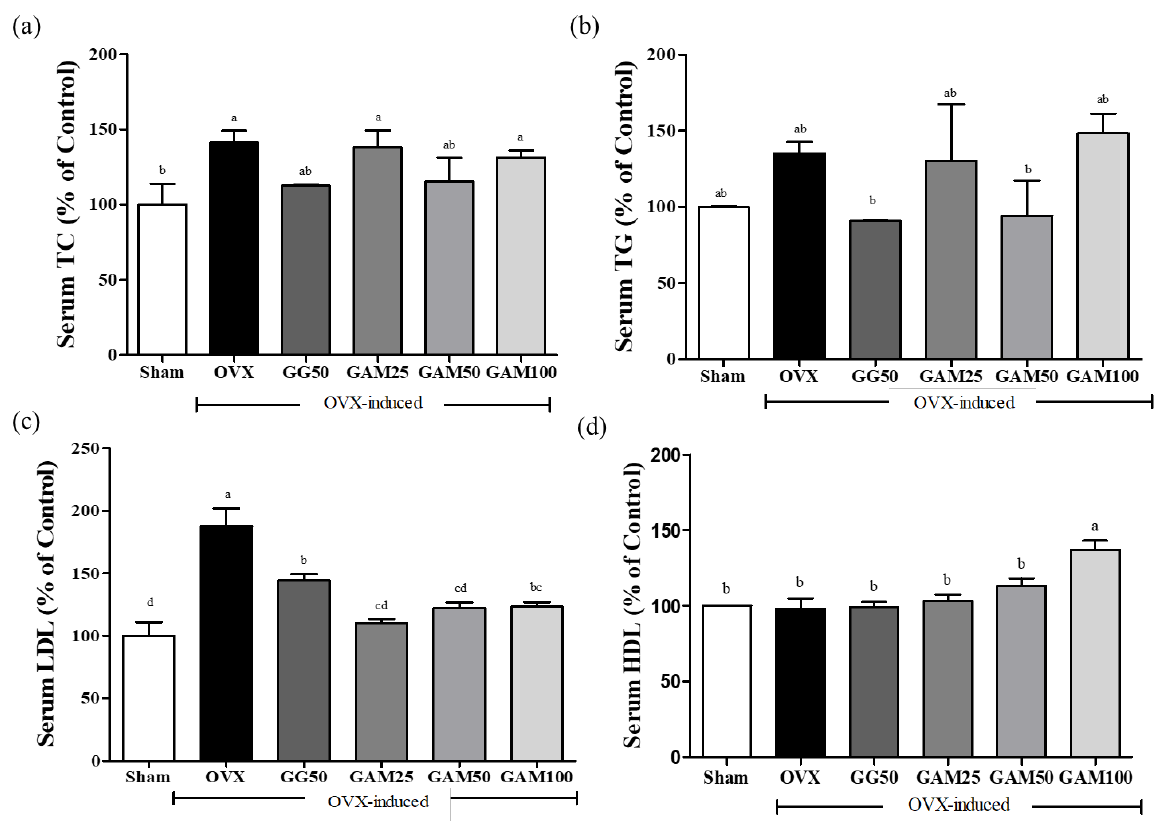
Figure 1. Effects of GAM on body lipids on OVX-induced rat models. The effects of GAM on ( a ) TC, ( b ) TG, ( c ) LDL, and ( d ) HDL were evaluated using ELISA assay kit. a–d Mean values with different letters differed significantly ( p < 0.05) among groups, as shown by Tukey’s test.